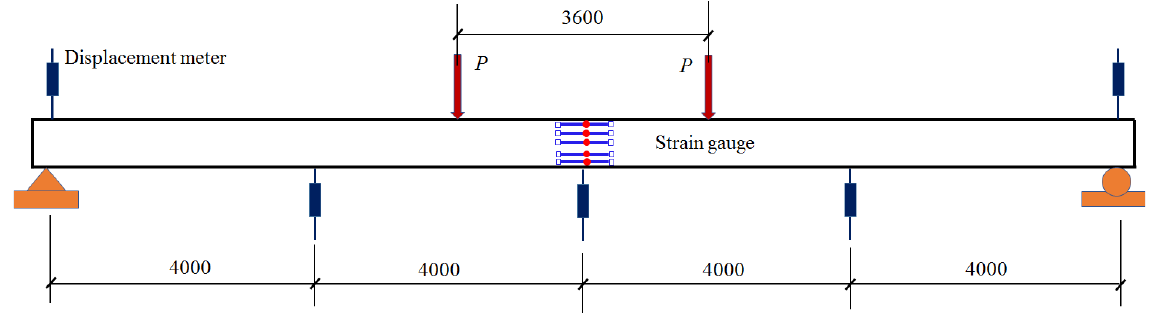
Figure 4. Arrangement of the repaired beam under four-point bending test.